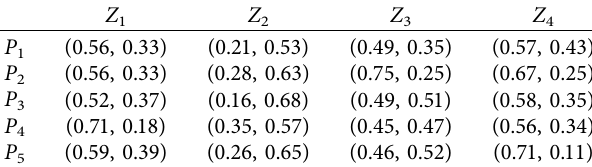
Table 2: Intuitionistic fuzzy matrix by H